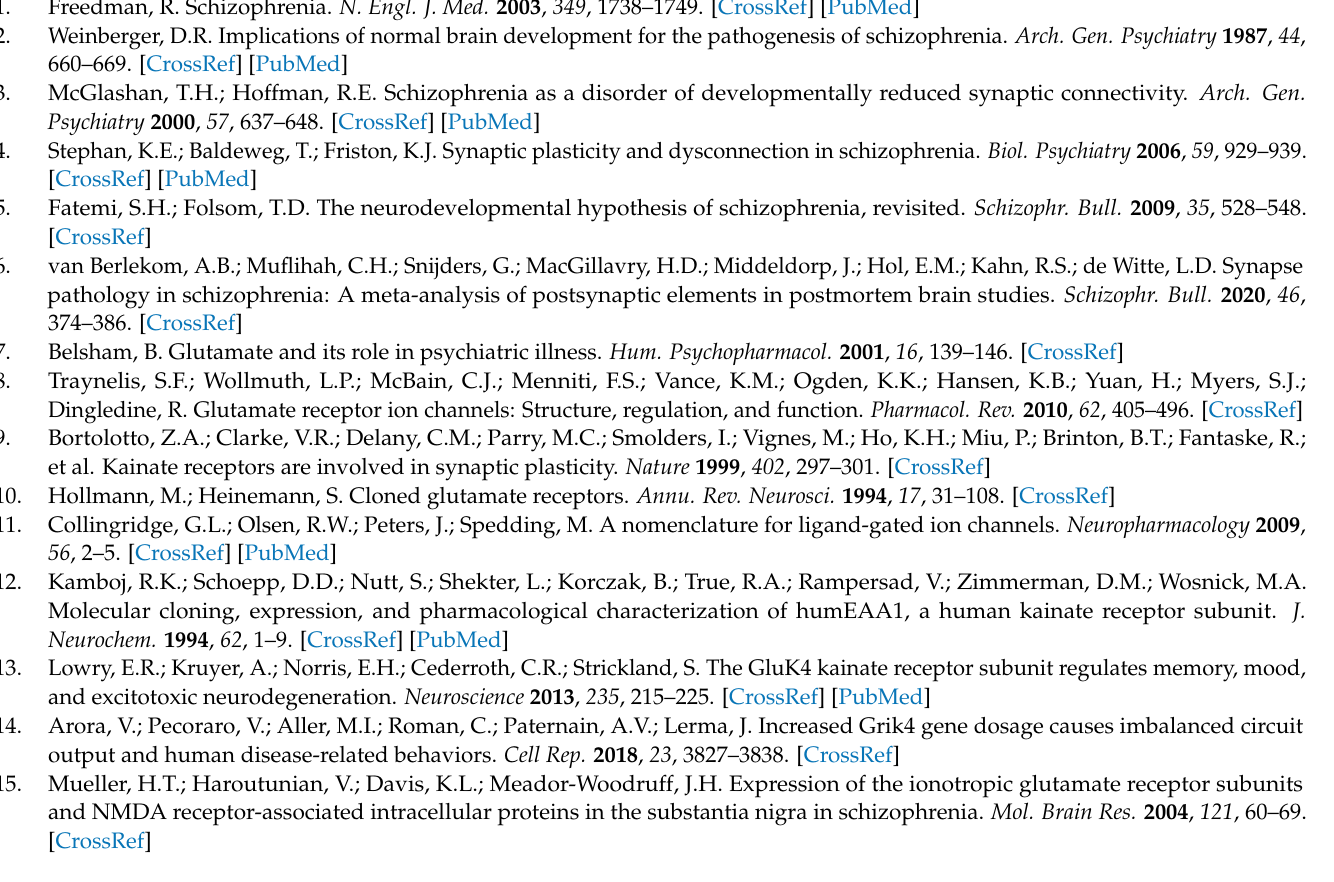
Supplementary Figure S2: The mRNA expression of the GRIK1 , GRIK2 , GRIK3 , GRIK4 , and GRIK5 gene in peripheral blood cells, lymphoblastoid cells, and the human brain; Supplementary Figure S3: Localization analysis of GRIK gene family mutants in HEK-293